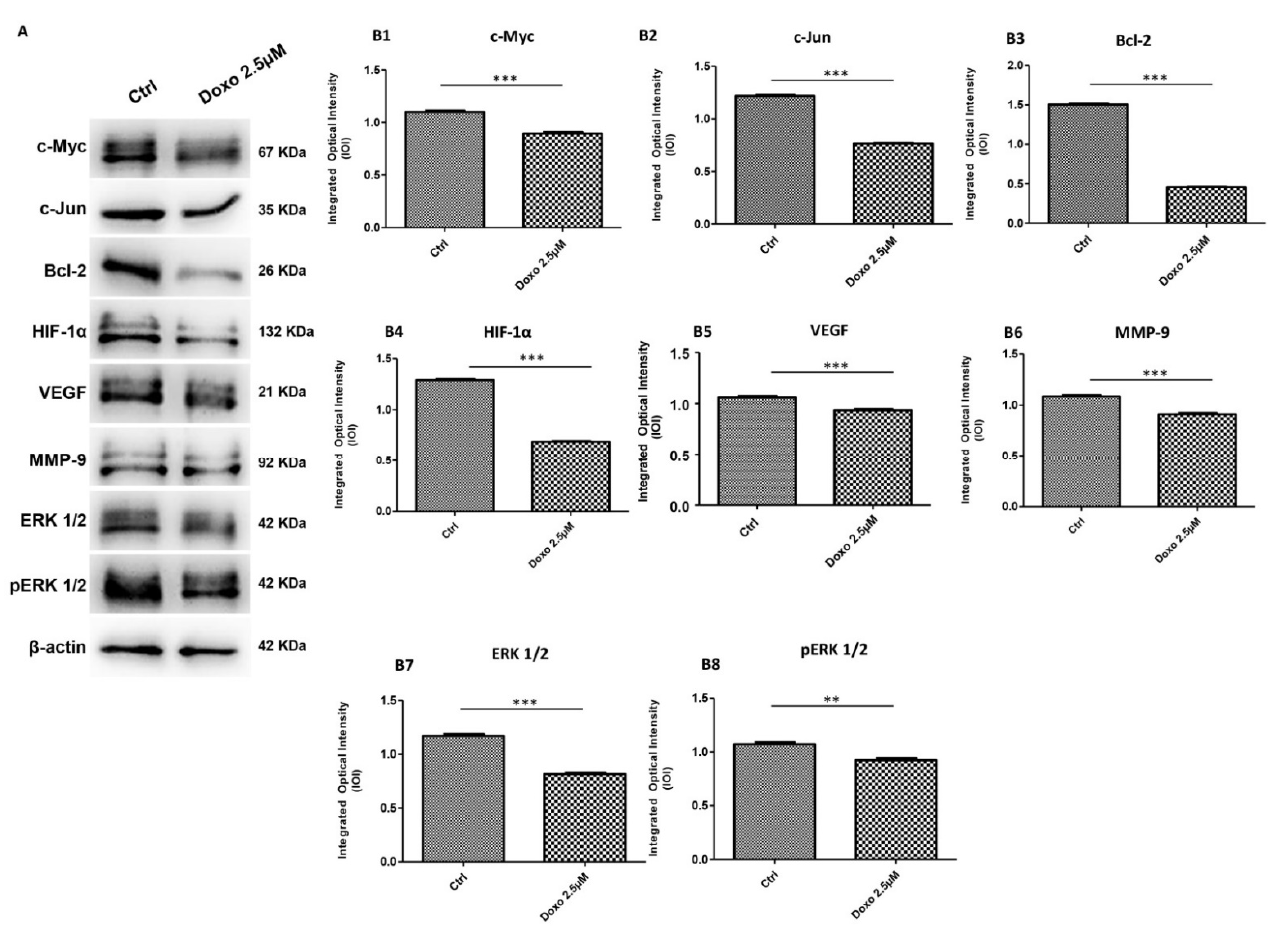
Figure 6. Western blotting analysis. ( A ) c-Myc, c-Jun, Bcl-2, HIF-1 α , VEGF, MMP-9, ERK 1/2 and pERK1/2 proteins expression in Cal-27 cell line untreated and treated with 2.5 µM Doxo. Each membrane was probed with β -actin antibody to verify loading consistency. Western blot data shown are the representative data from three different experiments. ( B1 – B8 ) Histograms represent densitometric measurements of protein bands expressed as integrated optical intensity (IOI) mean of three separate experiments. The error bars show standard deviation (±SD). Densitometric values analyzed by t -test (unpaired t -test) return significant differences. *** p < 0.001, ** p < 0.01.